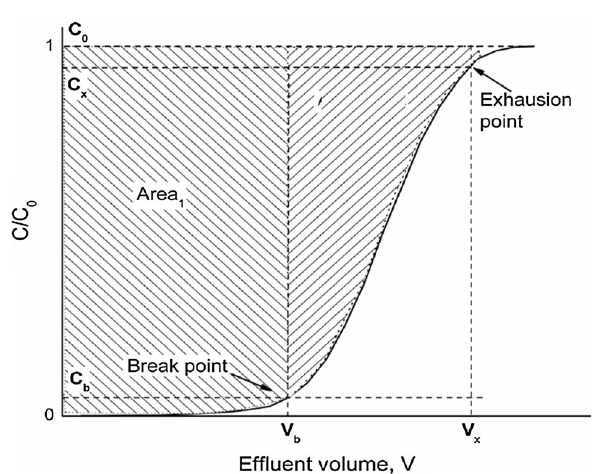
Fig. 2 Ideal breakthrough